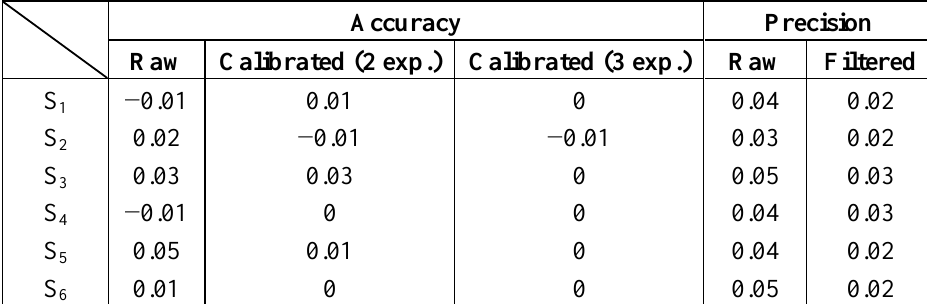
Table 2. Accuracy and precision of raw and corrected estimations. Columns 1 and 4: accuracy and precision of raw estimations. Columns 2 and 3: accuracy of estimations for a calibration using experiments at two (0.1, −0.05) and three (0.1, 0.02, −0.05) slopes respectively. Columns 5: Precision of estimations after applying a moving average filter to raw estimations. S stands for Subject n